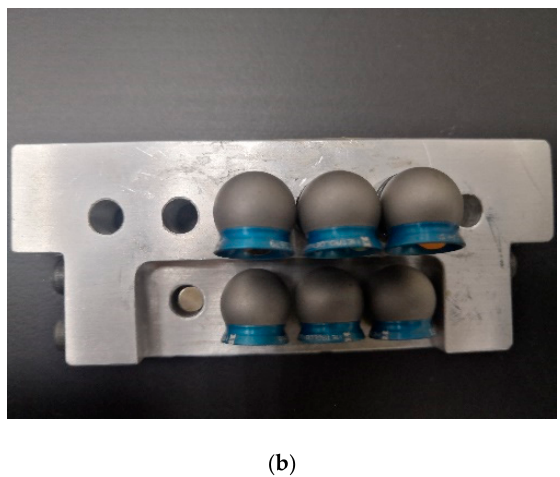
Figure 7. Calibration target: ( a ) standard ceramic spheres; ( b ) spherically mounted reflectors.